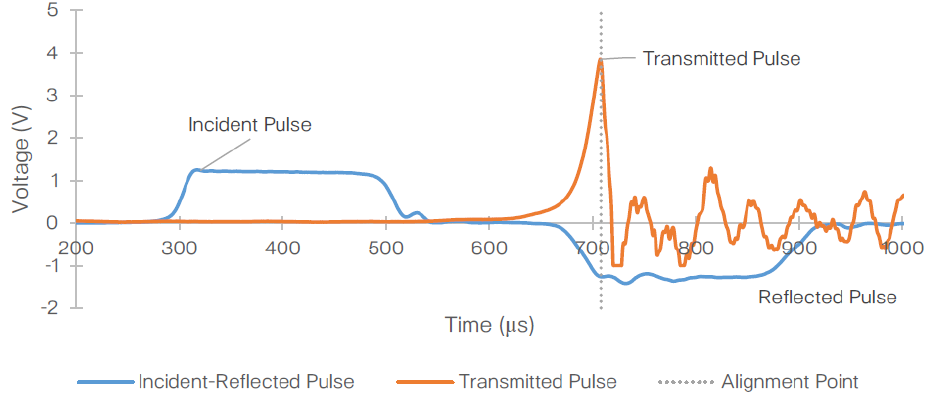
Figure 9. Representative raw signals obtained from one of the 2100/s strain rate following the SHPB experiment conducted on T700/PA6.6 specimen.